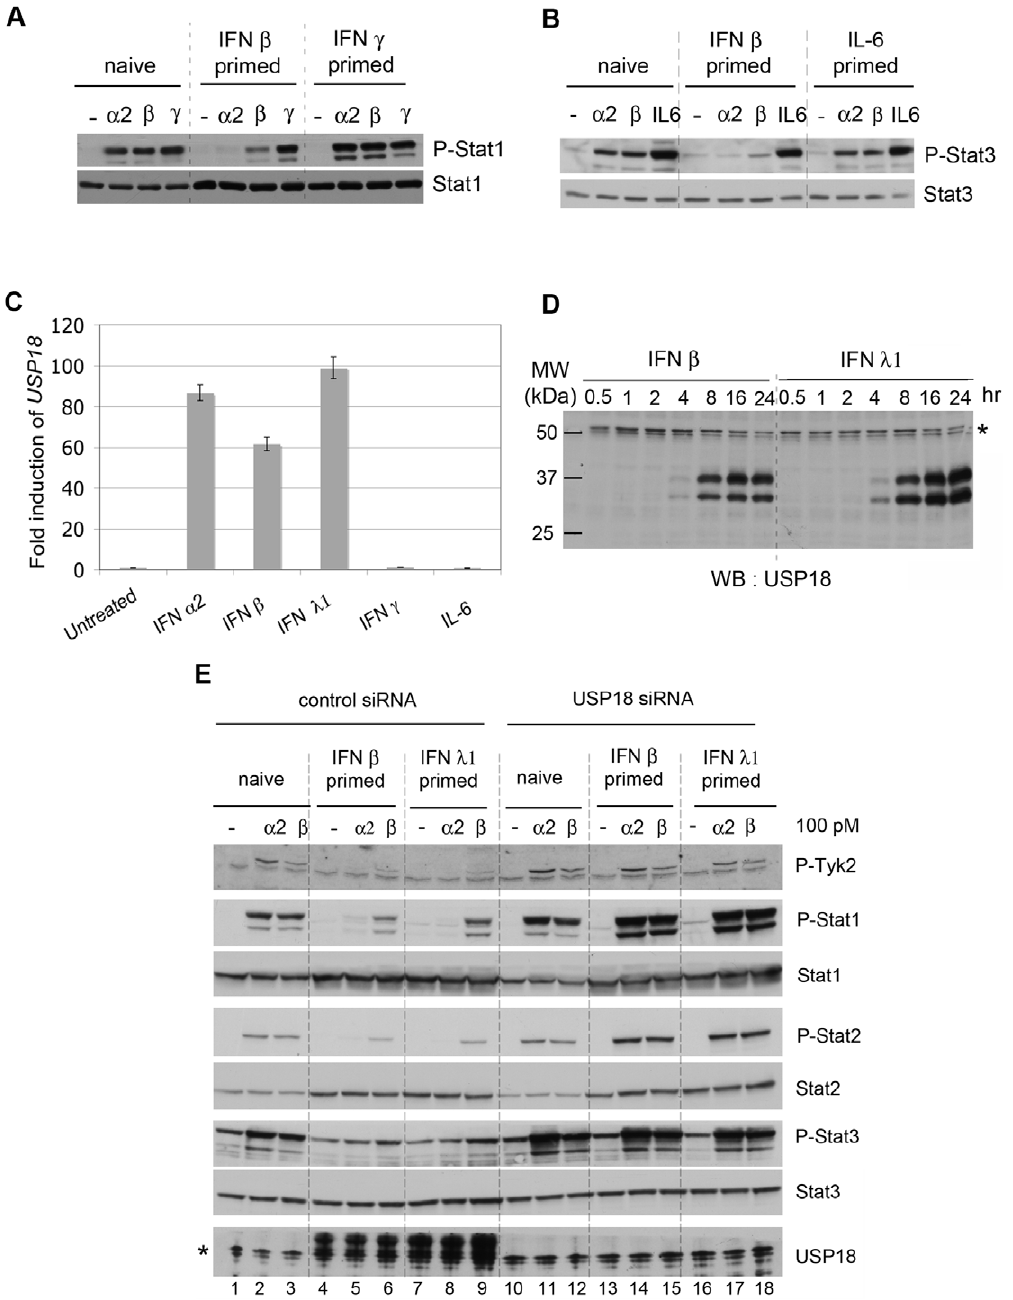
Figure 5. USP18 is necessary for differential desensitization. (A) Stat1 phosphorylation induced in HLLR1-1.4 cells stimulated for 30 min with IFN a 2 (100 pM), IFN b (100 pM) or IFN c (1 ng/ml) in naı¨ve cells and in cells primed with either IFN b (500 pM) or IFN c (10 ng/ml). Cells were primed for 8 hr and maintained without IFN for 16 hr. (B) Stat3 phosphorylation induced in HLLR1-1.4 stimulated for 30 min with with IFN a 2 (100 pM), IFN b (100 pM) or hIL-6 (10 ng/ml) in naı¨ve cells and in cells primed with IFN b (500 pM) or hIL-6 (100 ng/ml). Cells were primed for 8 hr and maintained without IFN for 16 hr. Lysates (30 m g) were immunoblotted with the indicated Abs. (C) Level of USP18 mRNA in HLLR1-1.4 cells stimulated for 6 hr with IFN a 2, IFN b (500 pM), IFN l 1 (50 pM), IFN c (1 ng/ml) or hIL-6 (100 ng/ml) as determined by qRT-PCR. Each sample was run in triplicate. Transcripts were normalized to the level of 18S transcripts. The ratios between treated and untreated samples in each subset are shown, taking as 1 the ratio in untreated samples. (D) Kinetic profile of USP18 induction in HLLR1-1.4 cells stimulated with 100 pM of IFN b or IFN l 1 for the indicated times. Cell lysates (30 m g) were immunoblotted with the indicated Abs. The asterisk points to a nonspecific band. (E) USP18 is necessary for differential desensitization. HLLR1-1.4 cells were transfected with a control pool of siRNA (Control siRNA) or a pool of four USP18 targeting siRNA (USP18 siRNA). Twenty four hr after transfection, cells were either left untreated (naı¨ve) or primed for 8 hr with the indicated IFN. After 16 hr of resting, cells were stimulated for 30 min with 100 pM of IFN a 2 or IFN b . Cell lysates (30 m g) were analysed with the indicated antibodies. The asterisk in the bottom panel points to a band cross-reacting with anti-USP18 Abs (see also USP18 blot in Fig. 3C). Individual USP18 targeting siRNA were also used with similar results (data not shown).